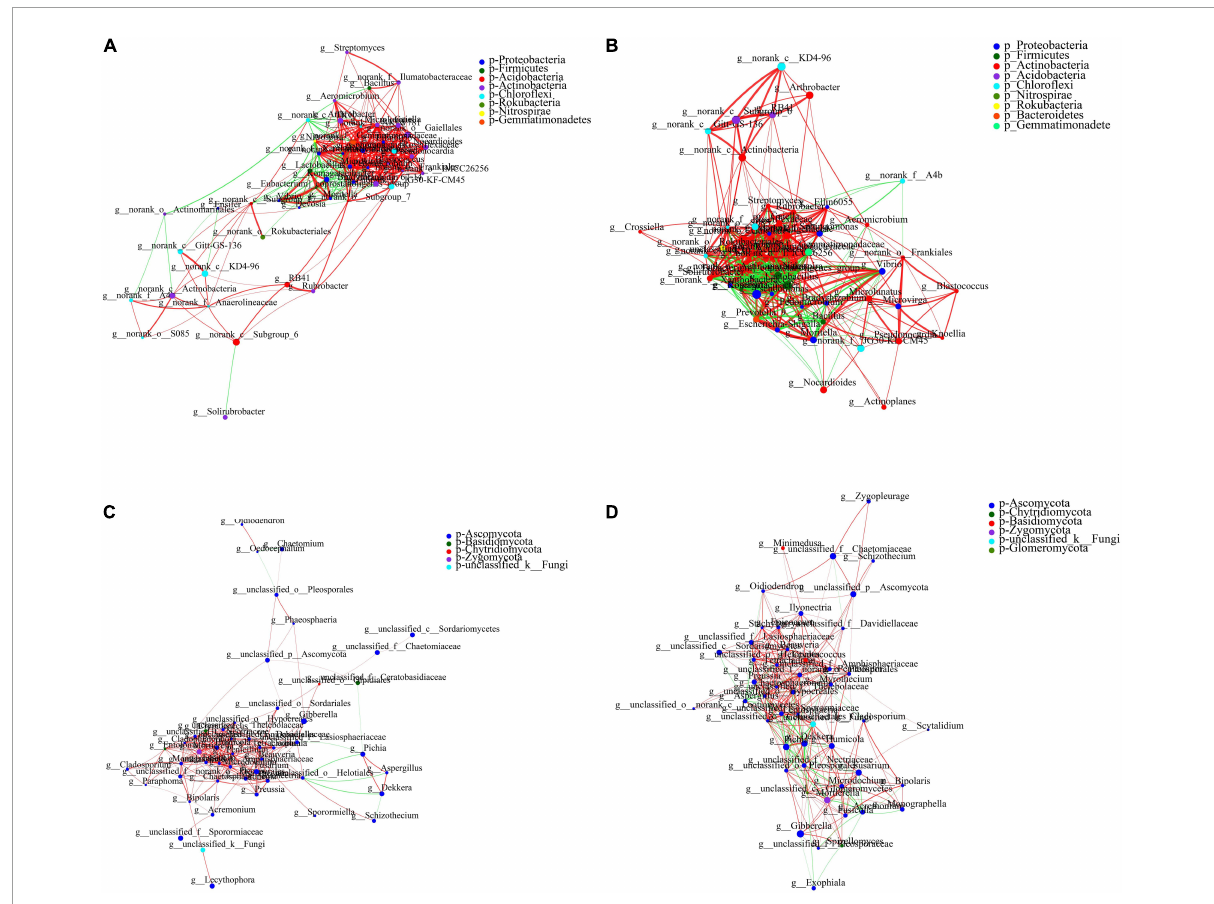
FIGURE6 Effect of ABA-PAM on the collinear network of soil microorganism. (A,B) Bacteria; (C,D) fungi; (A,C) ABA-PAM absent; (B,D) ABA-PAM